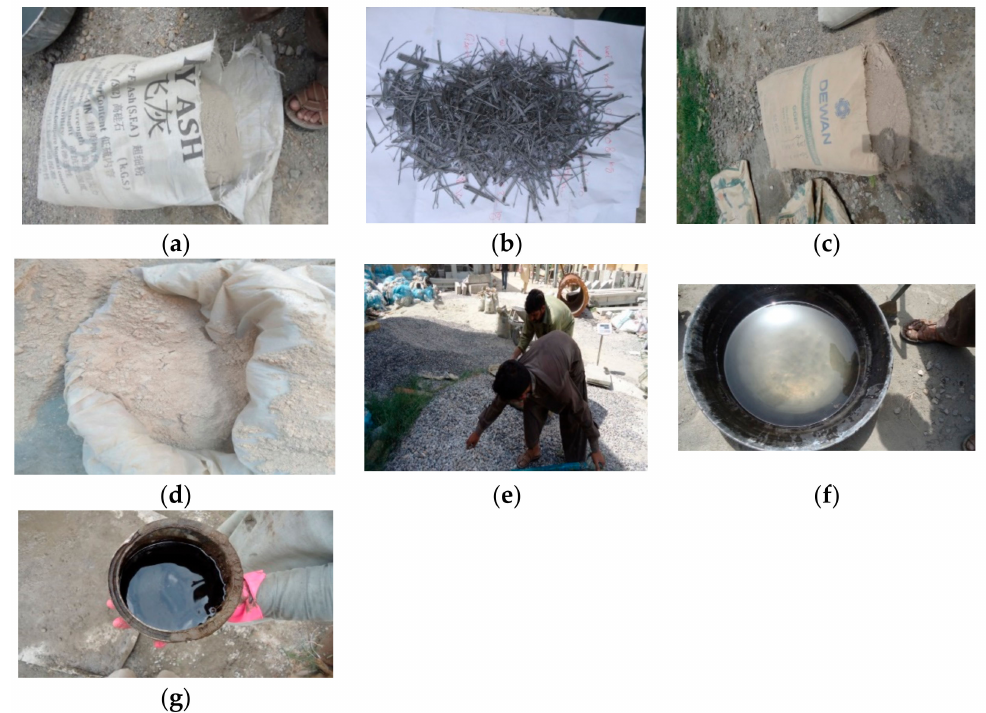
Figure 1. The materials used in the present study to produce QRD incorporated FA and SG-based GPC (QFS-GPC) reinforced with steel fibers; ( a ) fly ash, ( b ) ground granulated blast furnace slag, ( c ) steel fibers, ( d ) quarry rock dust at site, ( e ) aggregates, ( f ) alkaline solution, and ( g )